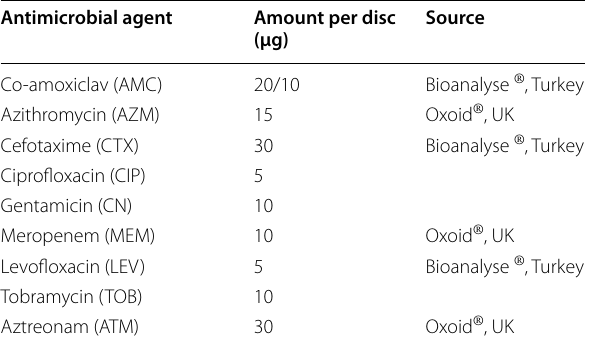
Table 1 Antimicrobial sensitivity discs, their concentrations, and sources